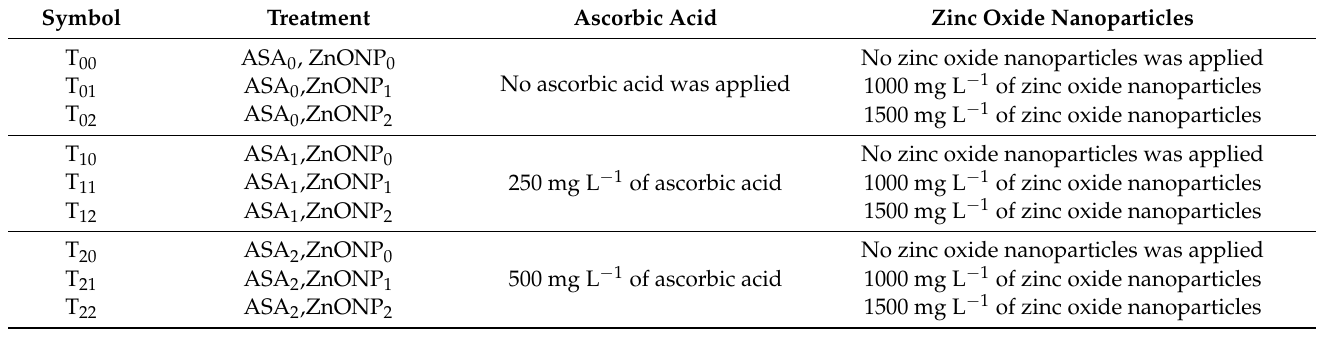
Table 2. The studied experimental treatments.